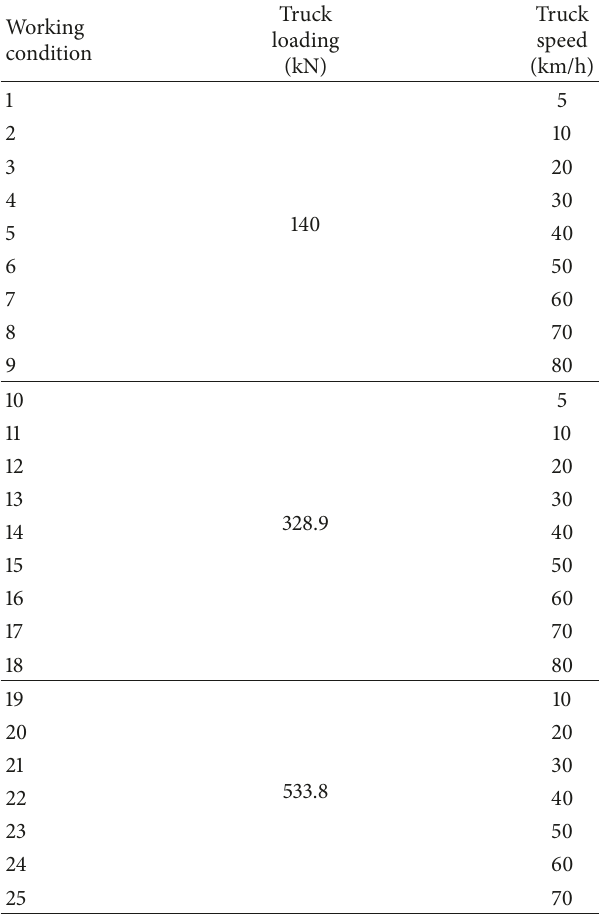
Table 2: Field tests under twenty-five working